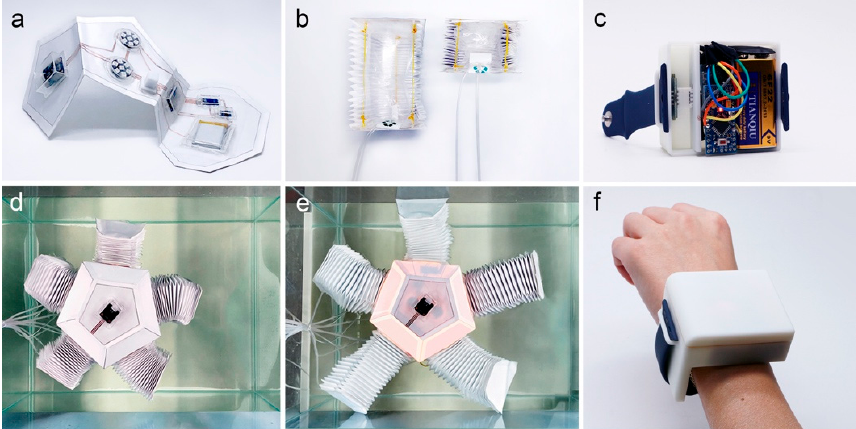
Figure 18. Starfish: ( a ) folded paper circuit; ( b ) deployable structure with airbag; ( c ) internal structure of the wristband; ( d ) in the self-protection state, the robot retracts its tentacles and darkens its body; ( e ) in the active state, the robot stretches its tentacles and lightens its body; and, ( f ) wristband for users to interact with the Starfish.